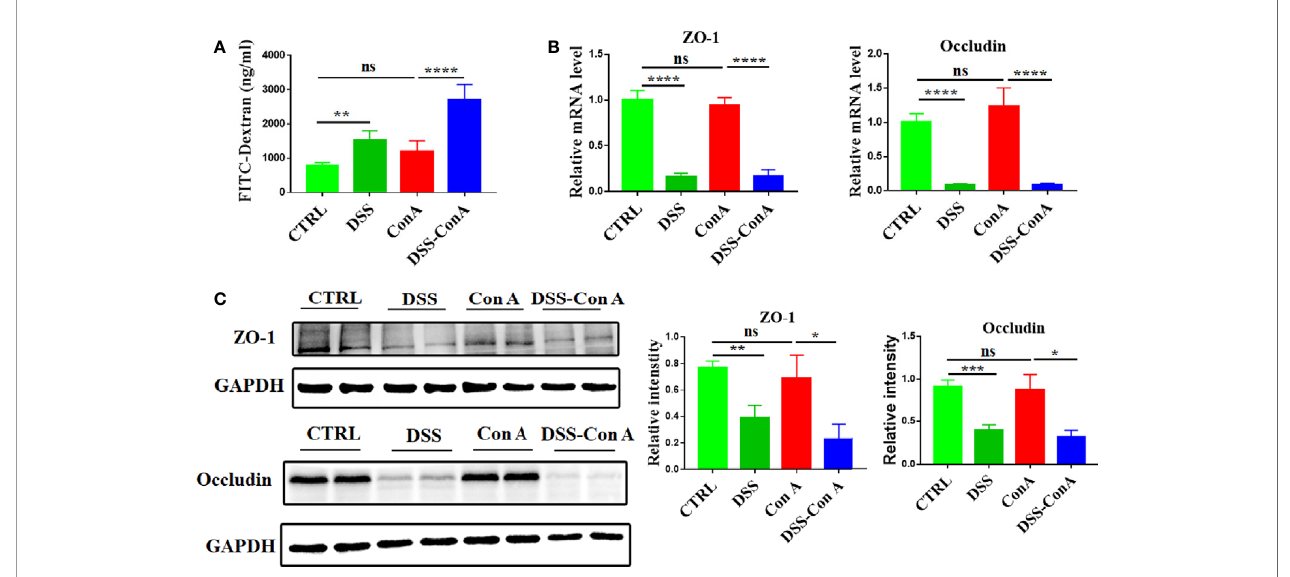
FIGURE 3 | Breakage of intestinal barrier integrity by 1%DSS. (A) FITC-dextran in vivo permeability assay in the four groups. (B) RT-qPCR analysis of ZO-1 and Occludin on tissue homogenates from the colon of the four groups. (C) Protein levels of ZO-1 and Occludin in the colon of the four groups were detected and the relative intensity was quanti fi ed. (n=6). The data were presented as means ± SD (Student ’ s t-test, *p < 0.05, **p < 0.01, ***p < 0.001, ****p < 0.0001, ns: p <